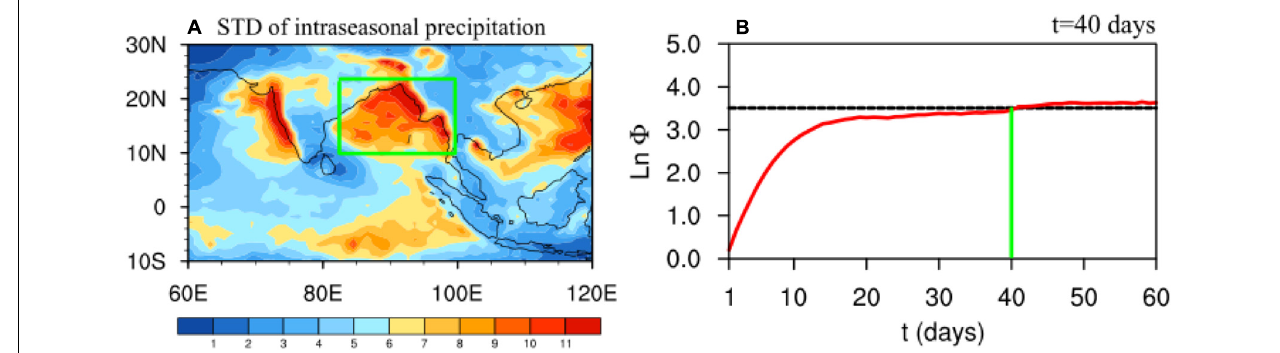
FIGURE 1 | (A) The standard deviation of intraseasonal precipitation (mm/day) during boreal summer (June–September). (B) Mean error growth (red line) of the regional mean daily intraseasonal precipitation during boreal summer over 85–100 ◦ E and 10–24 ◦ N (green box in A ) calculated by the NLLE method. The black dashed line marks the 98% level of the saturation value. The green line marks the predictability limit of 40